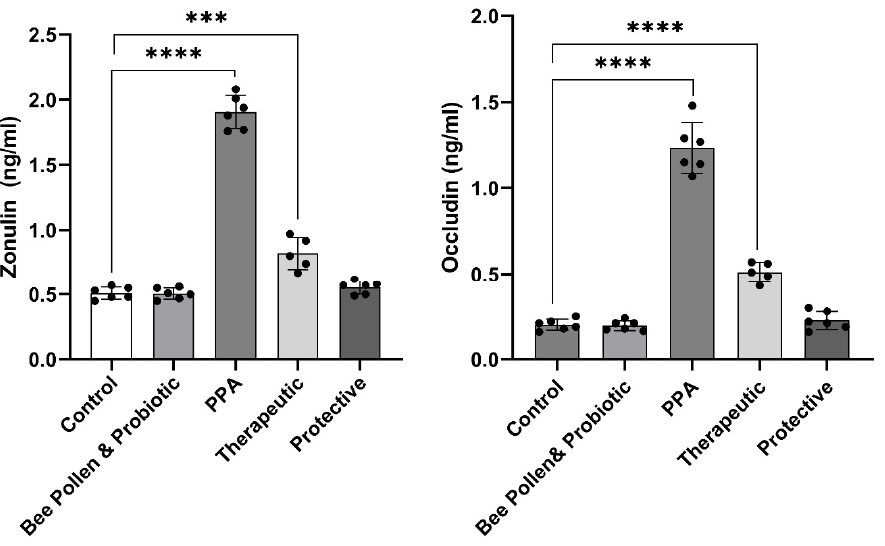
Figure 2. Effect of PPA treatment, protective, and therapeutic effects of bee pollen/probiotics on serum intestinal permeability related variables. Data presented are means ± standard error. Multiple comparisons by Tukey’s post hoc test *** p ≤ 0.001, **** p ≤ 0.0001. PPA, propionic